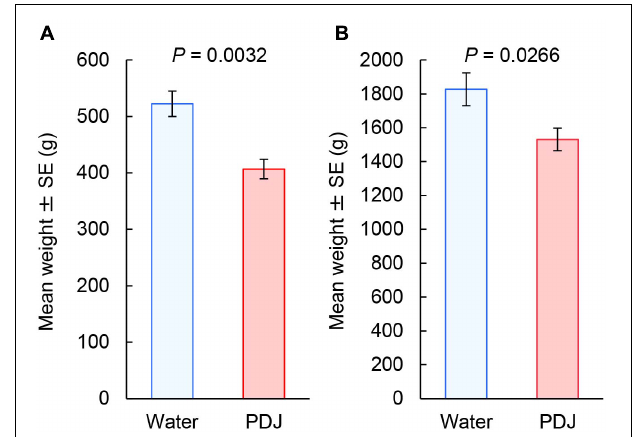
FIGURE 4 | Weights (g) of both the aboveground (A) and belowground (B) parts of Japanese radish plants treated with PDJ and water